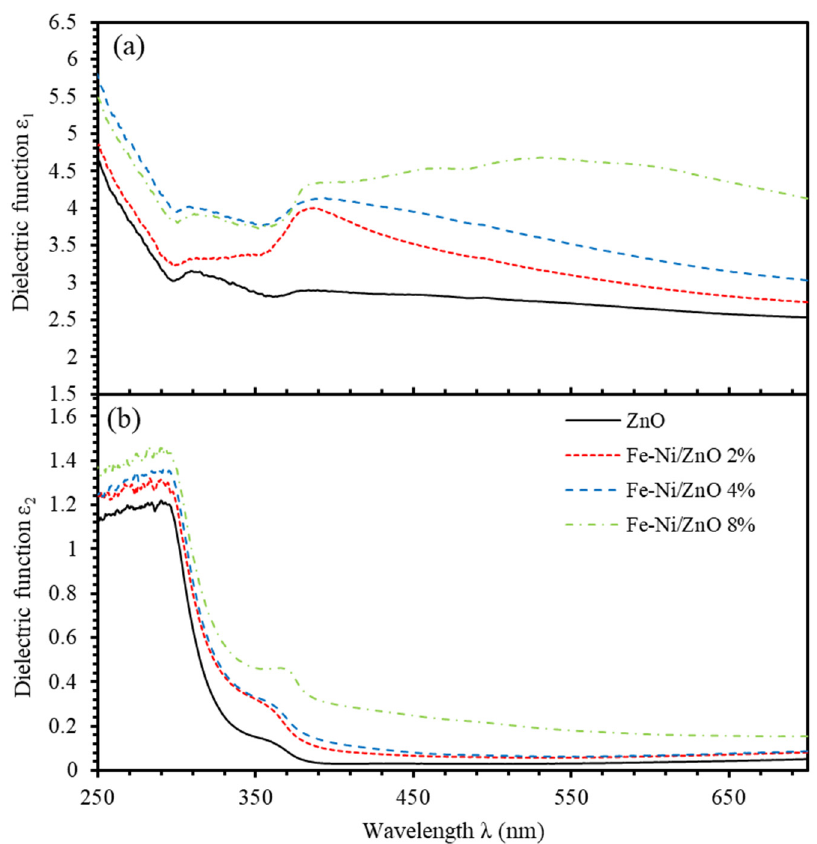
Figure 8. ( a , b ) Dielectric functions ( ε 1 ) and ( ε 2 ) of undoped ZnO and Fe-Ni co-doped ZnO thin films Figure 8. ( a,b ) Dielectric functions ( ɛ 1 ) and ( ɛ 2 ) of undoped ZnO and Fe-Ni co-doped ZnO thin films for di ff erent Fe-Ni co-doping for different Fe-Ni co-doping levels.